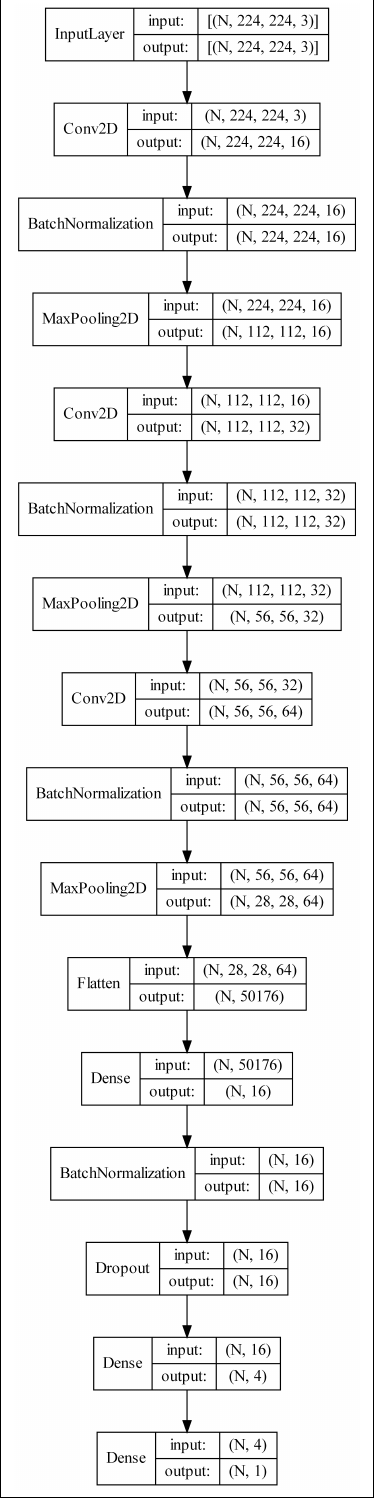
Figure 8. Structure of convolutional neural network (CNN) with property or satellite